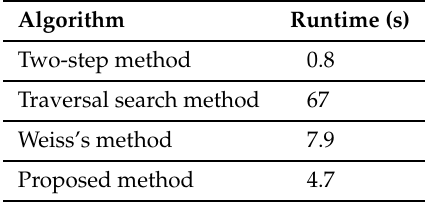
Table 4. Mean runtime of different methods.